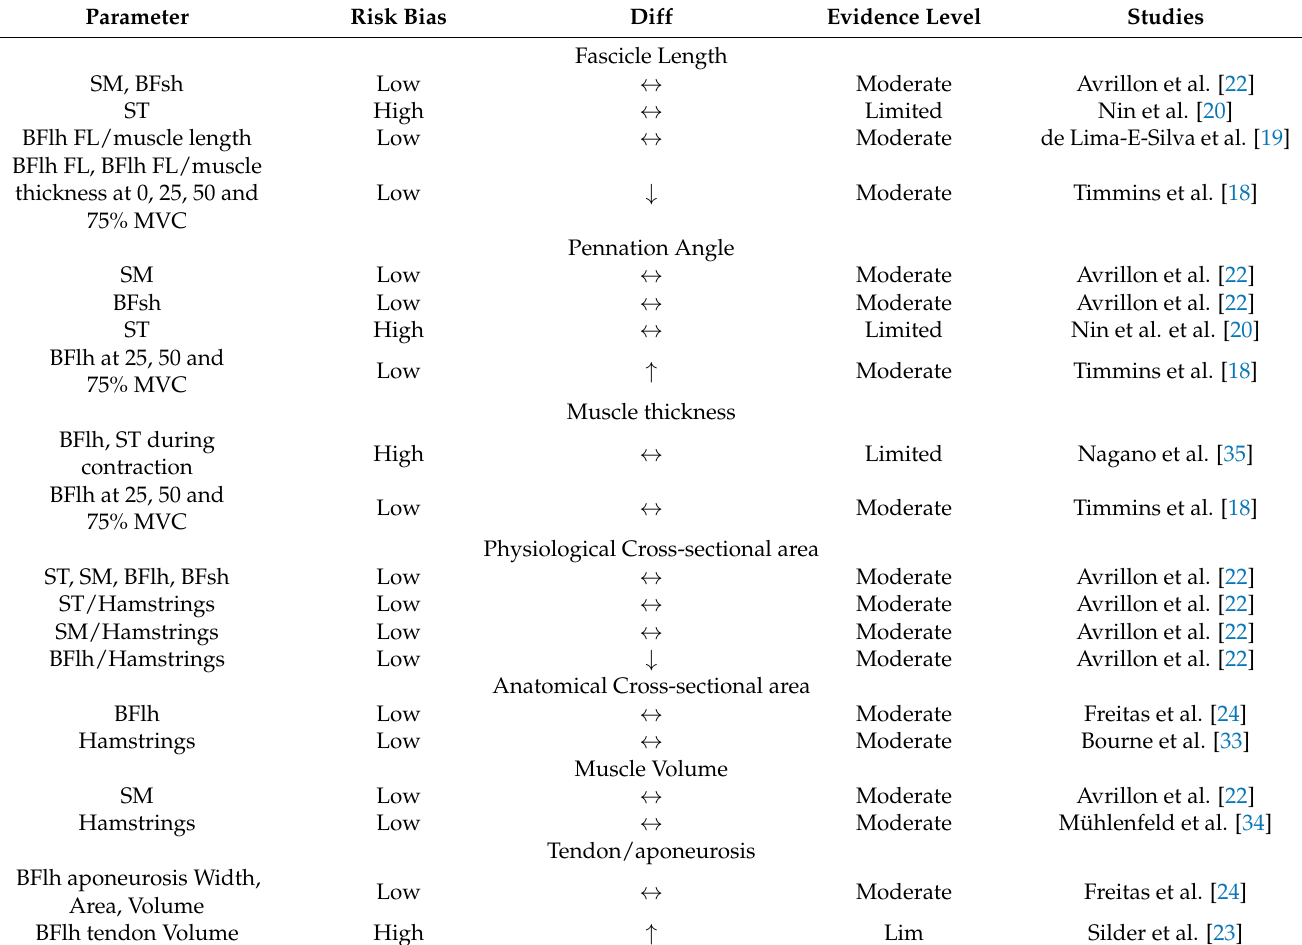
Table 3. Results of best evidence synthesis of studies that compared muscle architecture between injured and non-injured limb in participants with previous hamstring